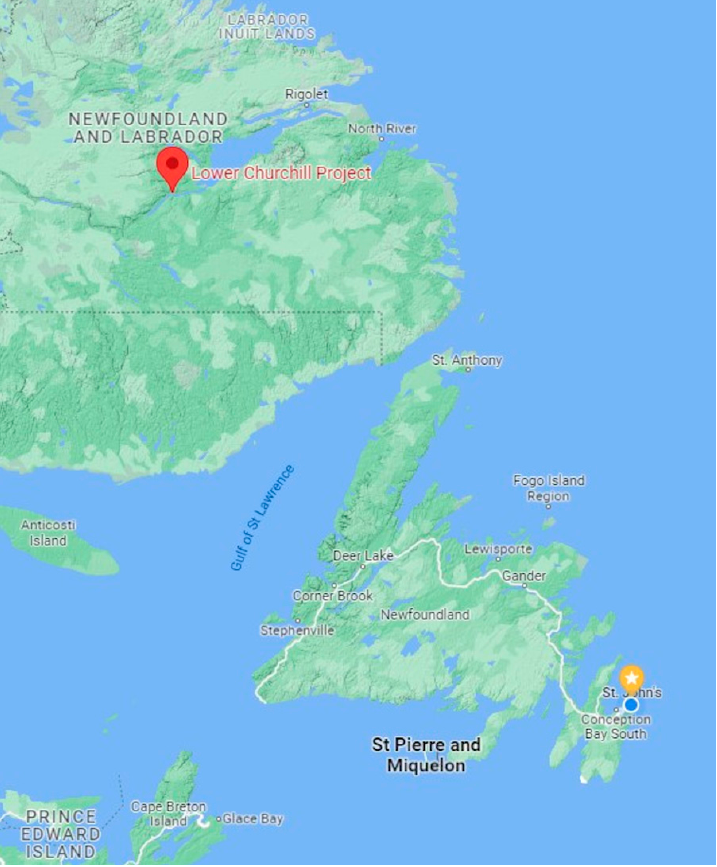
Figure 1. Location of the Muskrat Falls (the Lower Churchill Project). Source: Map data ©2022 Google.